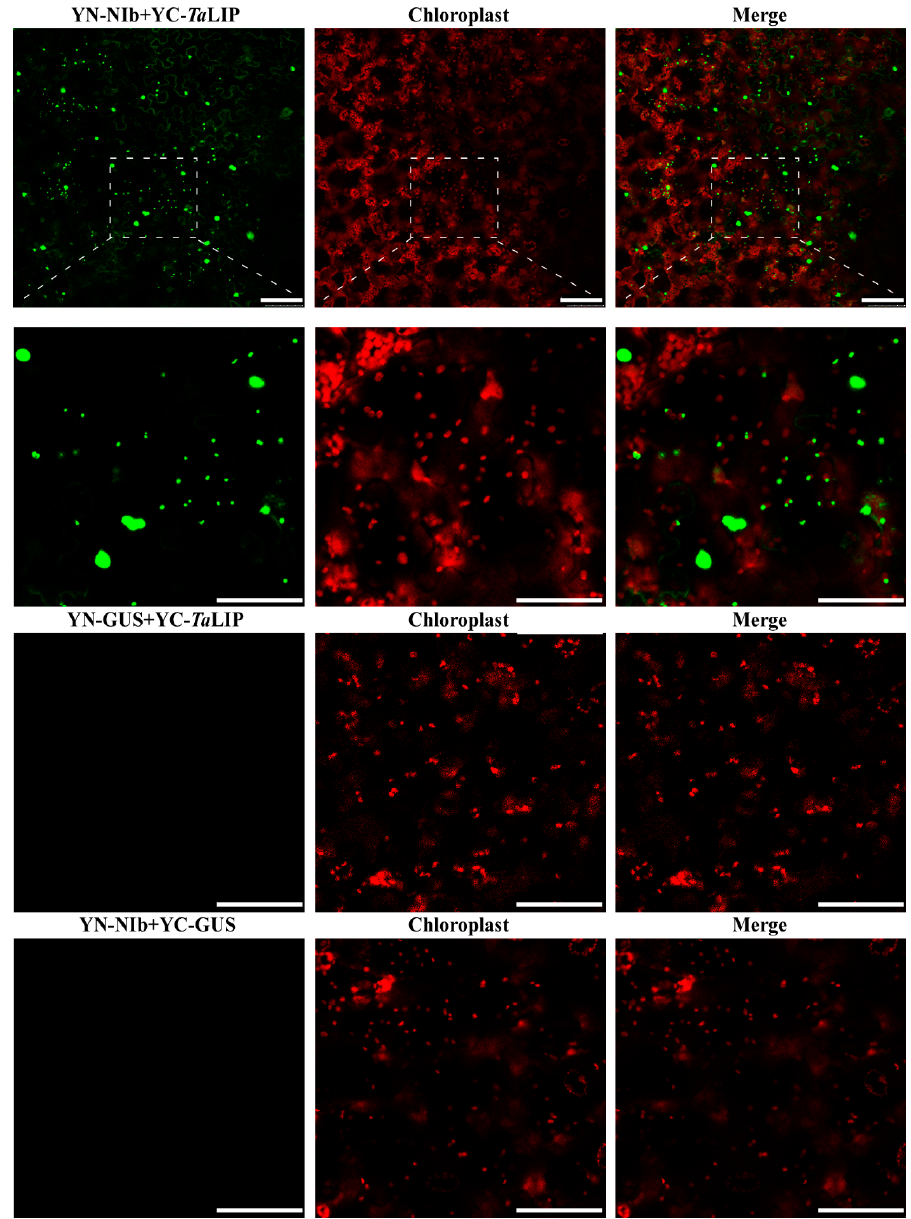
Figure 4. Bimolecular fluorescence complementation (BiFC) assay of the WYMV NIb and Ta LIP interactions in Nicotiana benthamiana . The pseudo-color of the Yellow fluorescent protein (YFP) signal was changed into green for convenience. The red fluorescent signal is a chloroplast auto-fluorescence signal. β -Galactosidase (GUS)-fused vectors pGTQL1211-GUS-cYFP/pGTQL1221-NIb-nYFP (YN-NIb/YC-GUS) and pGTQL1221-GUS-nYFP/pGTQL1211- Ta LIP-cYFP (YN-GUS/YC- Ta LIP) are the negative controls. Fluorescence photographs were taken at 3 dpi. Scale bar: 50 μ m.